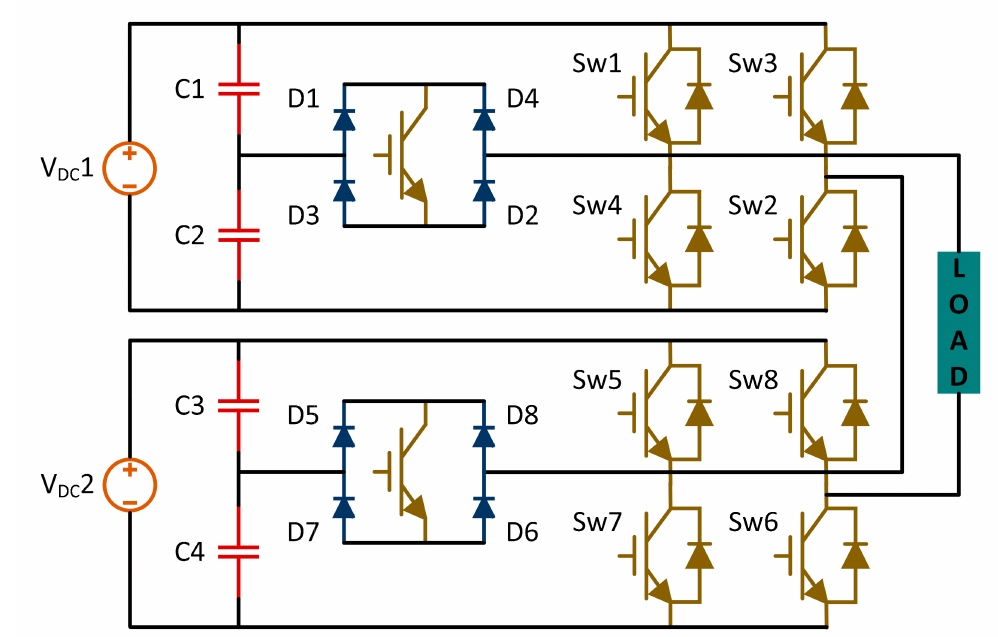
Figure 10. Topology of hybridized cascaded H-bridge multilevel